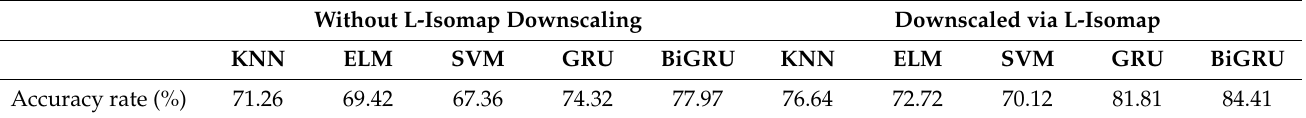
Table 8. Comparison of Diagnosis Results Before and After Dimensionality Reduction of Different Models.